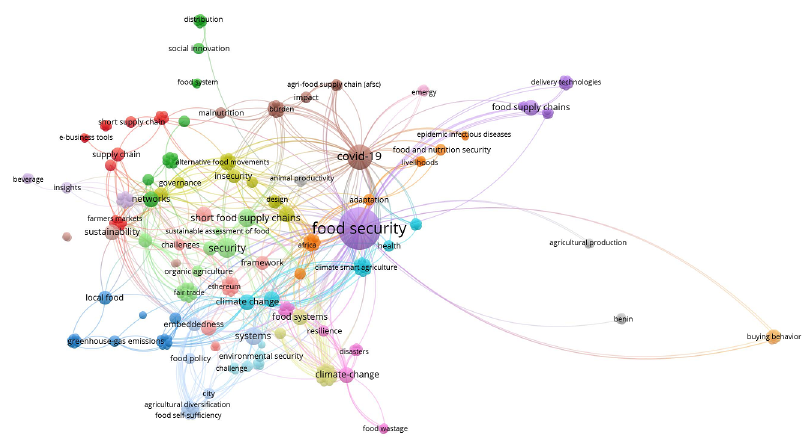
Figure 6. Keywords analysis of research in the food security and short supply chain area,